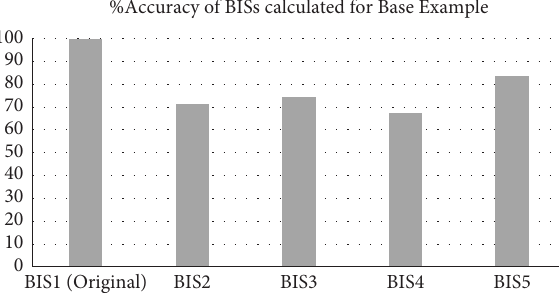
Figure 5: Accuracy of BISs recalculated through BISGA for the base example.